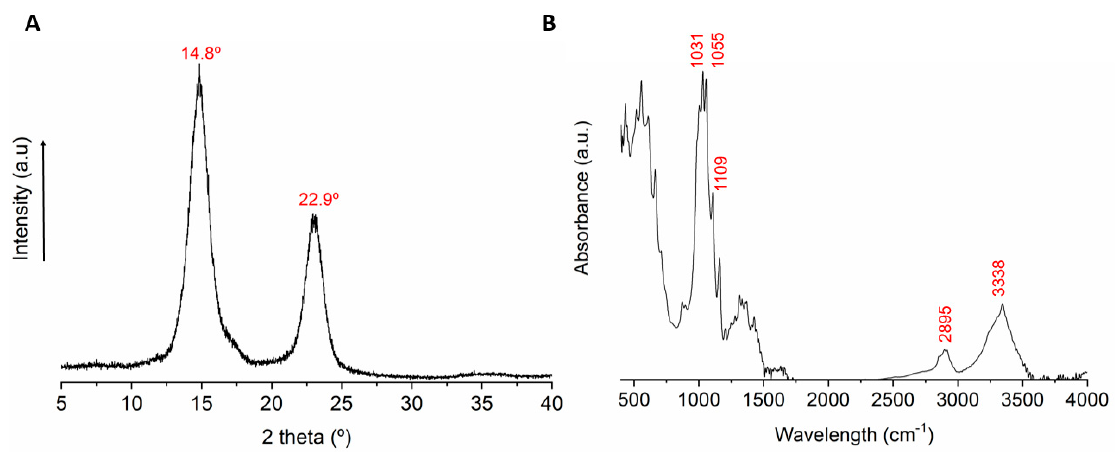
Figure 3. ( A ) X-ray diffraction (XRD) diffractogram of KBC showing the high crystallinity of the sample due to the narrow double peak. ( B ) Fourier transformed infrared (FT-IR) spectrum of KBC with typical bands of pure cellulose.